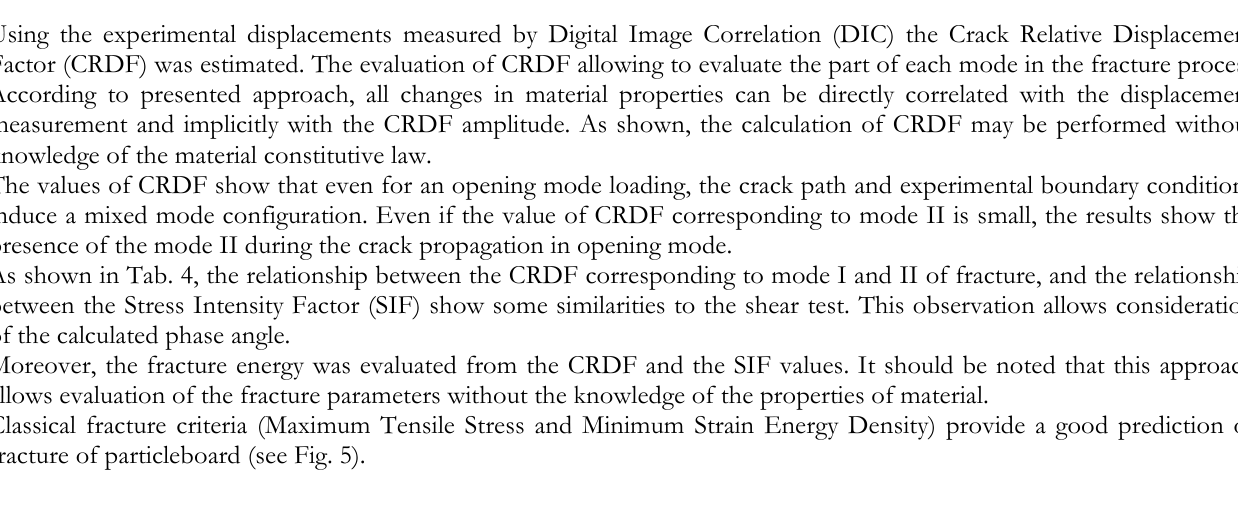
Table 6: A comparison of mechanical and fracture properties for